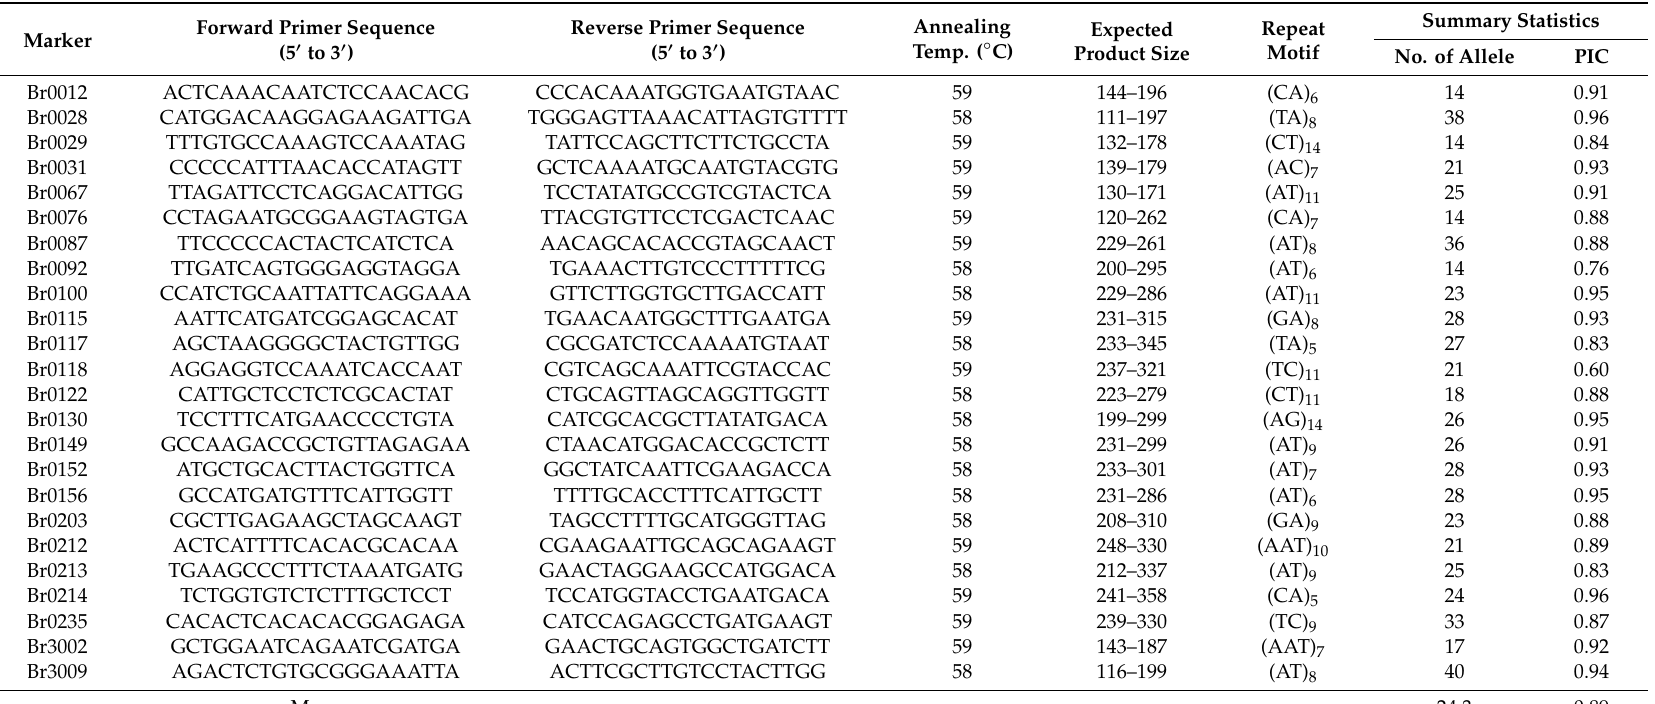
Table 1. Characteristic of 24 Single Sequence Repeats (SSR) markers and marker summary